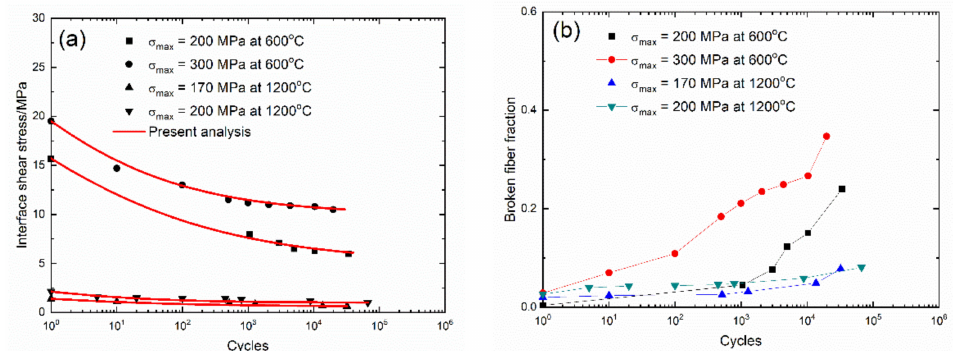
Figure 11. ( a ) Experimental and predicted interface shear stress ( τ i ) versus cycle number curves; and ( b ) the broken fiber fraction (P) versus cycle number curves of 2.5D woven self-healing Hi-Nicalon TM SiC / [Si-B-C] composite at 600 ◦ C and 1200 ◦ C in air and in steam atmospheres. ◦ At T = 600 C and σ max = 200 MPa, the interface shear stress ( τ i ) decreases from τ i = 15.7 MPa at N = 1 to τ i = 6.0 MPa at N = 33788, and the broken fiber fraction (P) increases from P = 0.004 to P = 0.24; and under σ max = 300 MPa, the interface shear stress ( τ i ) decreases from τ i = 19.5 MPa at N = 1 to τ i = 10.5 MPa at N = 19,812, and the broken fiber fraction (P) increases from P = 0.029 to ◦ P = 0.347. However, at T = 1200 C and under σ max = 170 MPa, the interface shear stress ( τ i ) decreases from τ i = 5.5 MPa at N = 1 to τ i = 1.7 MPa at N = 32,334, and the broken fiber fraction (P) increases from P = 0.0007 to P = 0.12; and under σ max = 200 MPa, the interface shear stress ( τ i ) decreases from = 5.1 MPa at N = 1 to τ = 2 MPa at N = 66794, and the broken fiber fraction (P) increases from τ i i P = 0.0008 to P = 0.14.